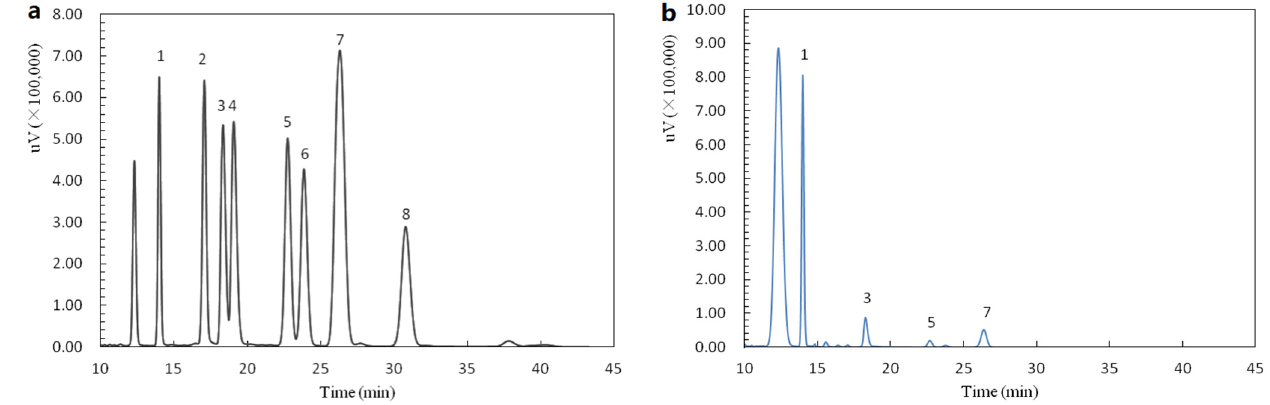
Figure 2. HPLC chromatograms of monosaccharide standards ( a ) and AAP-b2 ( b ). Peaks 1–8 represent mannose, rhamnose, glucuronic acid, galacturonic acid, glucose, galactose, xylose and fucose, respectively.